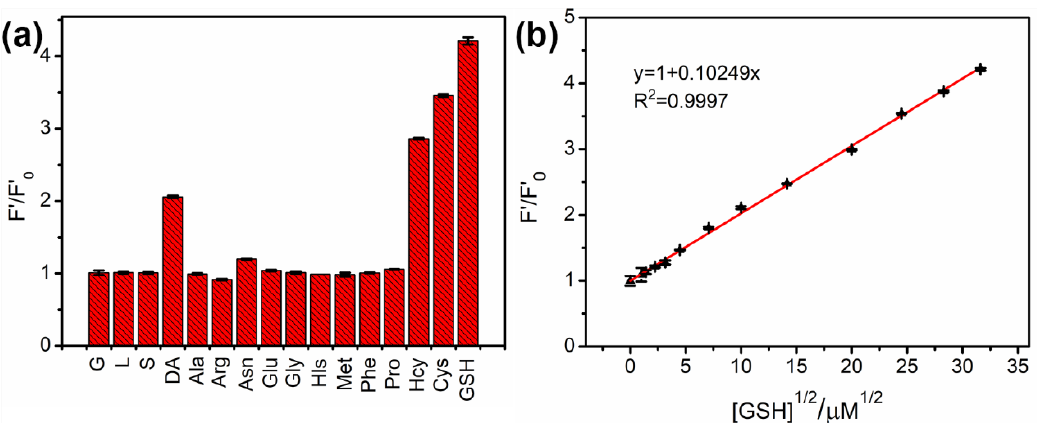
Figure 6. ( a ) Selectivity of N-CNPs/Fe(III) to different biological molecules at the same concentration (1 mM); ( b ) The linear relationship between (F’/F’ 0 ) and the square root of glutathione (GSH) concentration. F’ and F’ 0 were the PL intensities (424 nm) of N-CNPs/Fe(III) at 340 nm excitation in the absence and presence of biological molecules, respectively.